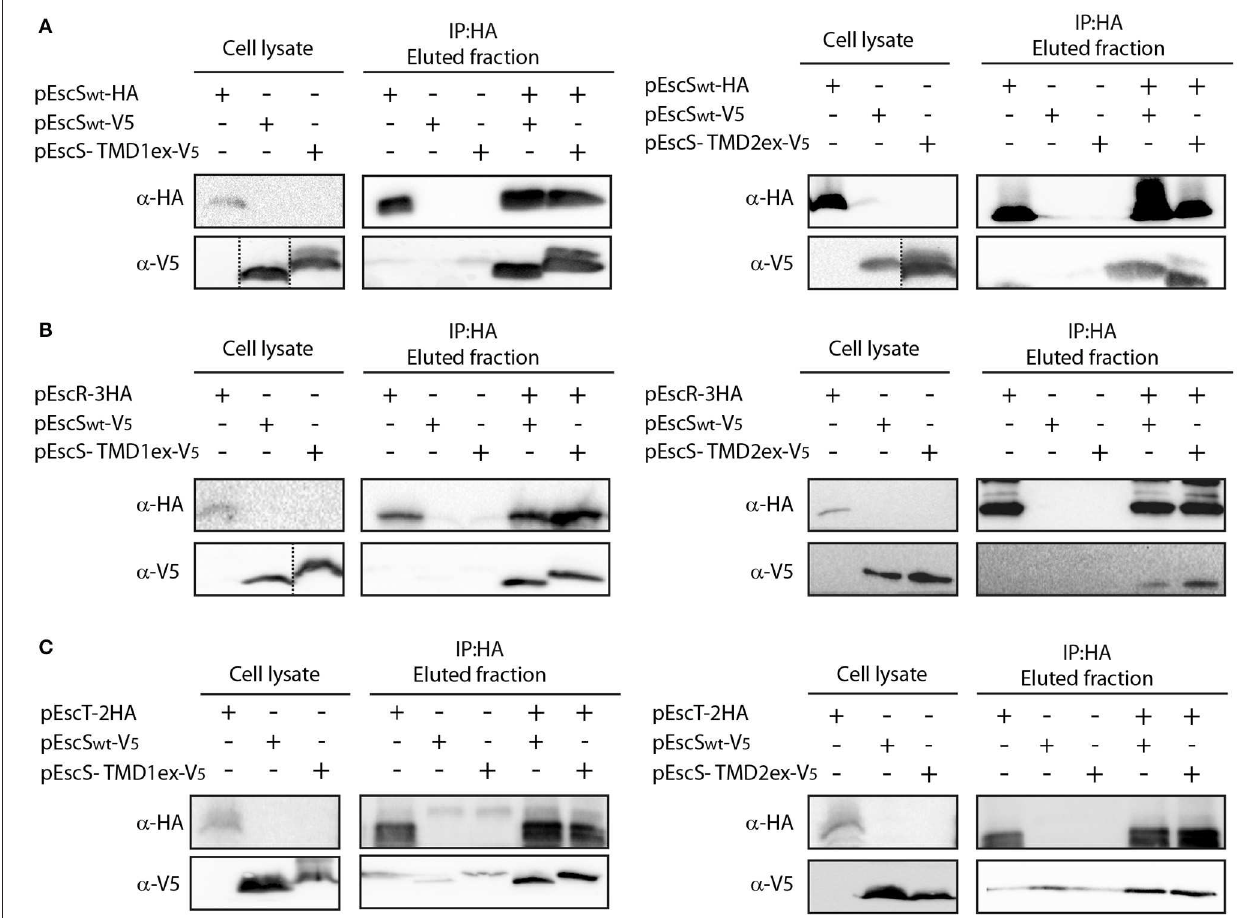
FIGURE 6 | EscS TMDs are not involved in EscS self- and hetero-interactions. Whole-cell lysates of E. coli expressing either EscS wt -V 5, EscS-TMD1 ex -V 5 or EscS-TMD2 ex -V 5 were mixed with EscS wt -HA (A) , EscR-3HA (B) , or EscT-2HA (C) and subjected to co-immunoprecipitation using protein G beads linked to an anti-HA antibody. Whole-cell lysates and eluted fractions were subjected to SDS-PAGE and western blot analysis with anti-HA and anti-V 5 antibodies.